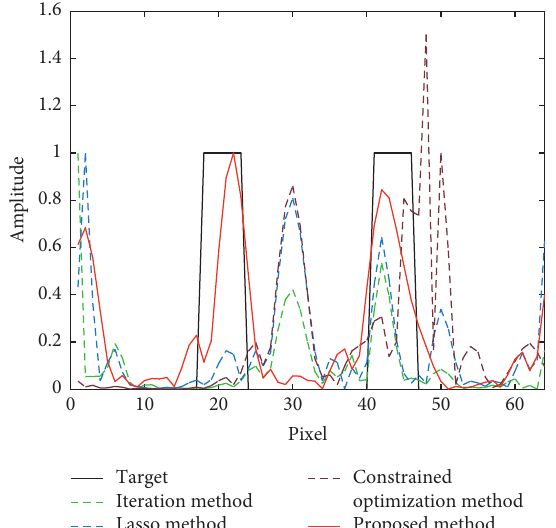
Figure 4: Sparse recovery results of one range of target with the constrained optimization method [14], iterative method [15], Lasso method, and proposed method ( M � N � 15, SNR � 20 dB, c � 15, and ρ � 0 .